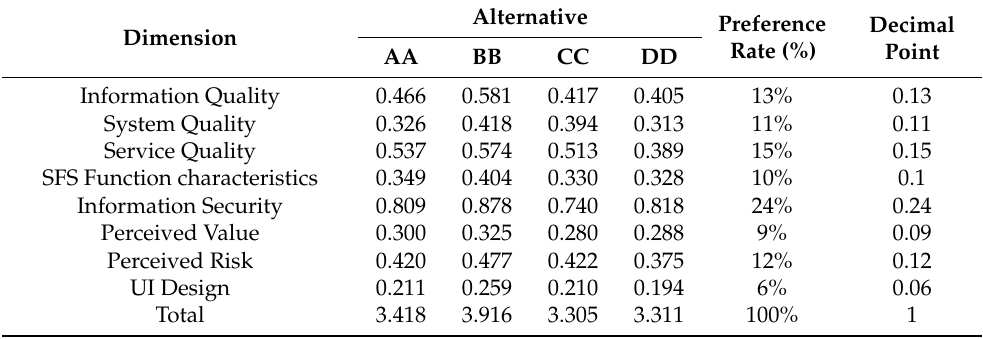
Table 10. Results of scoring suppliers.